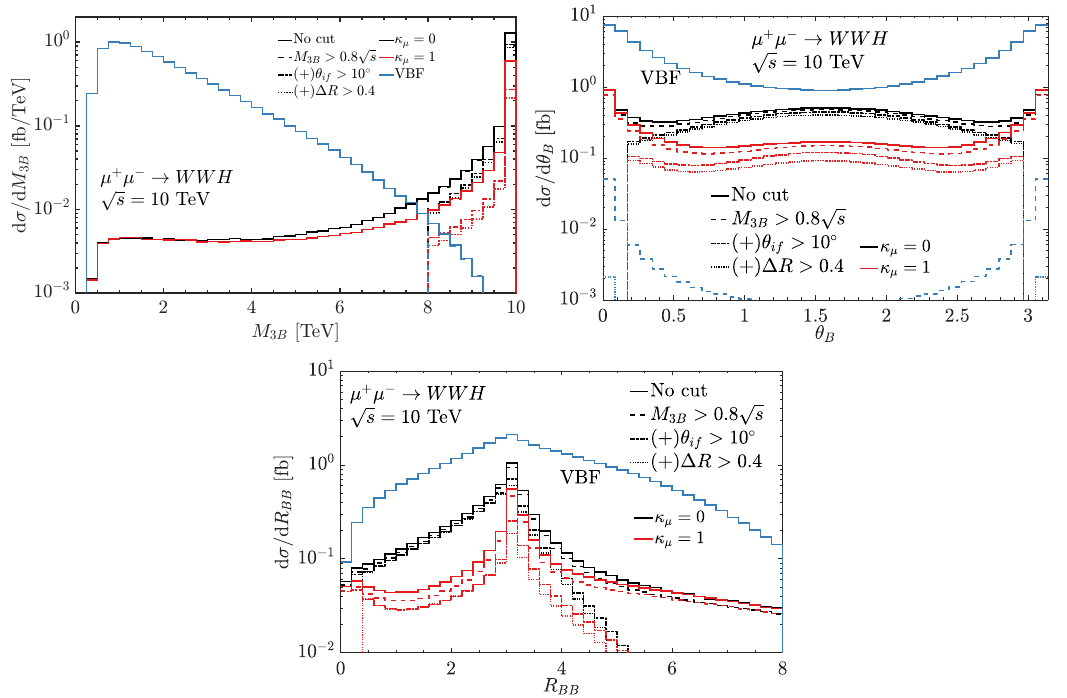
Figure 9 . The kinematic distributions of the boson angle θ B , the diboson distance R BB , and the triboson invariant mass M 3 B ( B = W, H ), respectively, in the WWH production at a µ + µ −